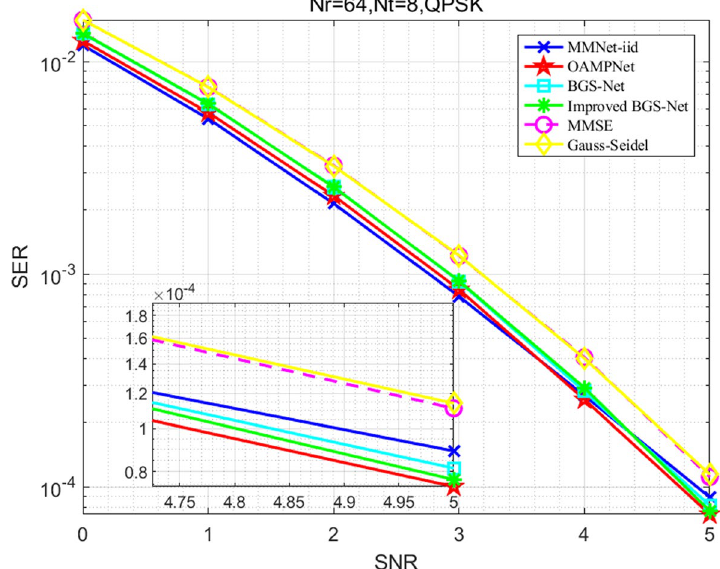
Fig. 30 The SER performance of the proposed detection algorithm when there is a channel estimation error in an uplink multi-user massive MIMO system, where N t = 8,N r = 64, σ 2 ǫ = 0.2